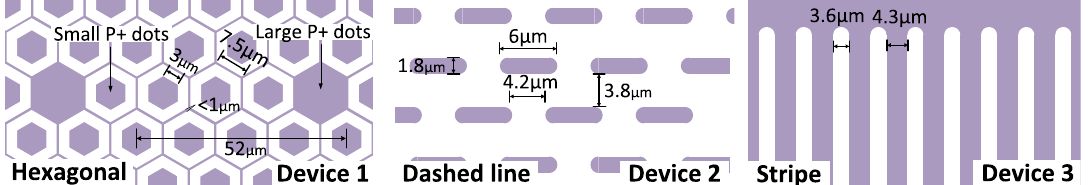
Figure 1. Layout designs of the three MPS diodes under test, drawn according to the microscopic observations. Colored regions stand for P + regions in the active region. Device 1 has large P + dots in its active